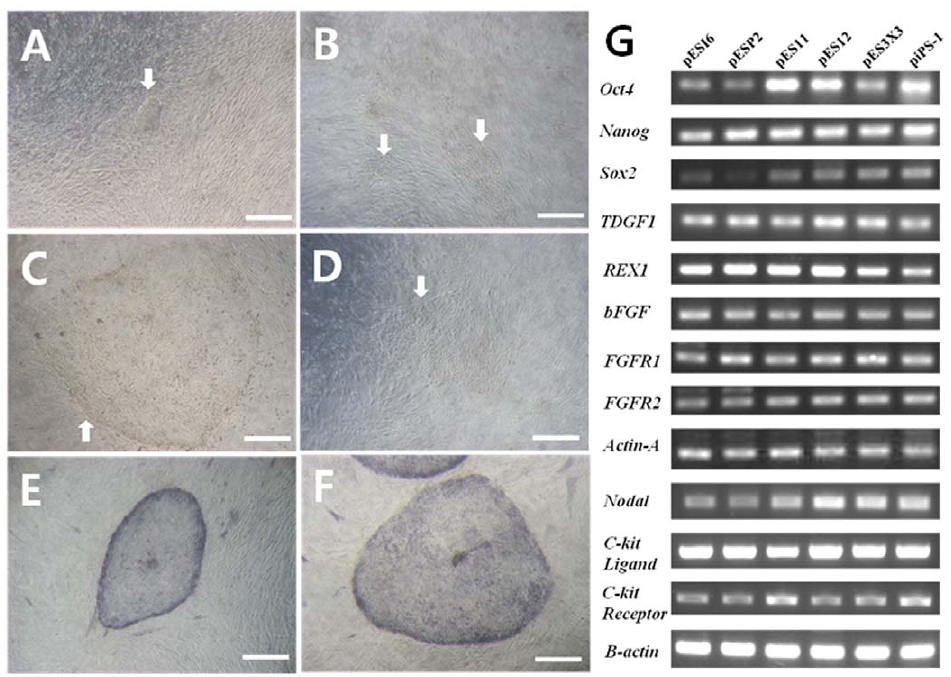
Figure 1. Derivation and gene expression analysis of porcine pluripotent cells. ( A ) Early morphology of EpiSC-like primary pESCs derived from porcine blastocysts. ( B ) Early morphology of EpiSC-like primary piPSCs derived from porcine embryonic fibroblasts. ( C ) Late morphology of EpiSC-like primary pESCs derived from porcine blastocysts. ( D ) Late morphology of EpiSC-like primary piPSCs derived from porcine embryonic fibroblasts. ( E ) AP activity of typical EpiSC-like pESCs. ( F ) AP activity of typical EpiSC-like piPSCs. ( G ) All of the pluripotent cells expressed the undifferentiated pluripotent stem cells markers Oct4, Sox2, Nanog, TDGF1 and Rex1 as well as the epiblast stem cell markers bFGF, FGFR1, FGFR2, Activin-A and Nodal. C-kit ligand and C-kit receptor, known growth factor for stem cell renewal, were also expressed in these cell lines. Scale bars=200 m m.